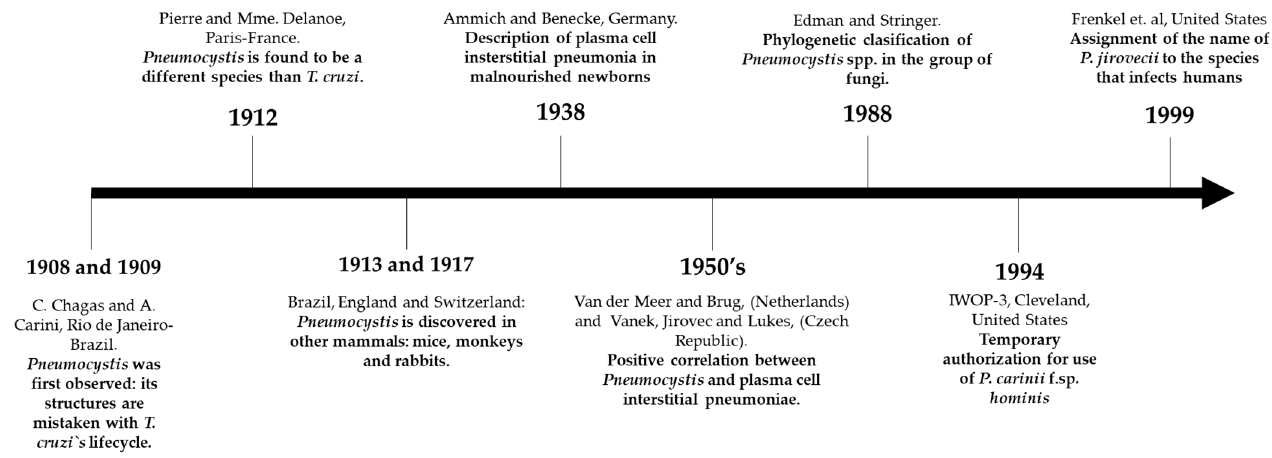
Figure 1 . Chronological illustration of the most important events in the discovery of Pneumocystis jirovecii from 1908–1999.